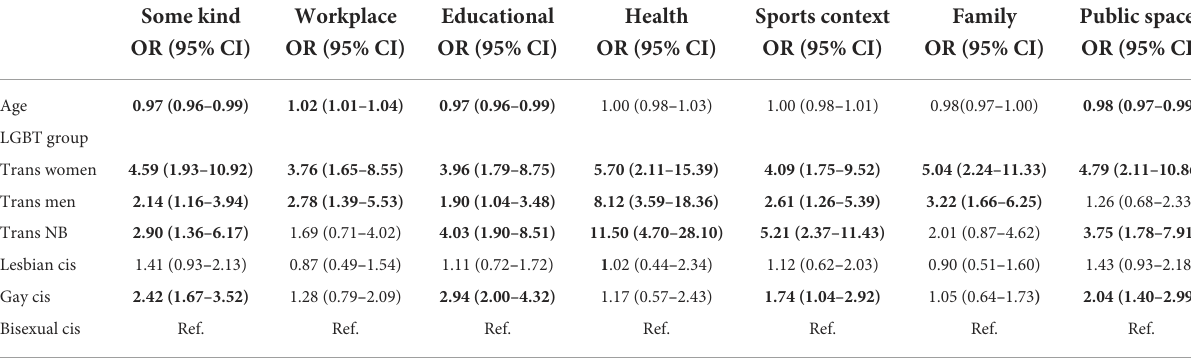
TABLE 3 Prediction model of harassment experience by age and LGBT groups ( n = 989). Some kind Workplace Educational Health Sports